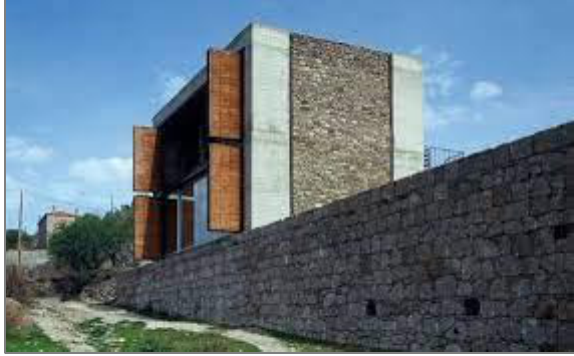
Figure 18 Han Tümertekin, B -2 House